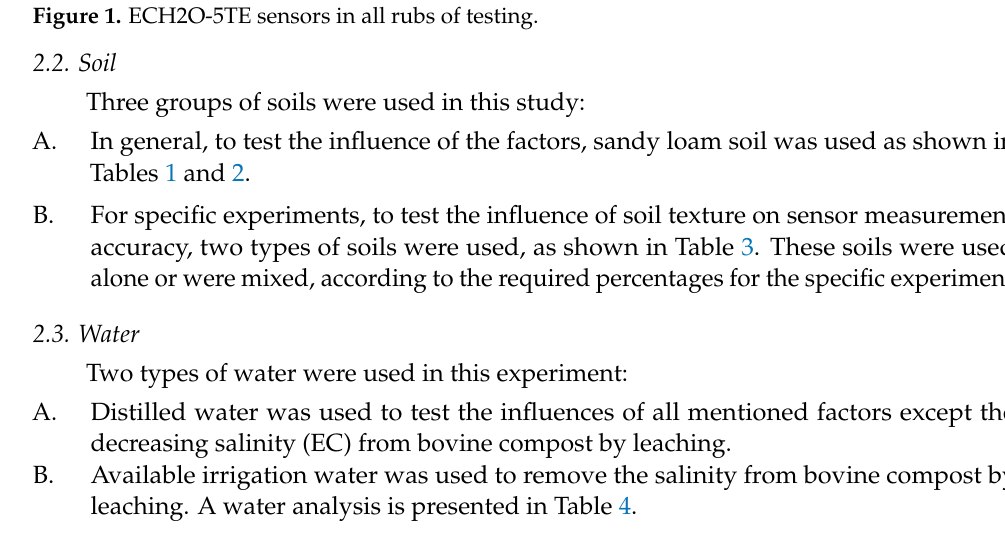
Table 1. Mechanical analysis of general empirical soil.